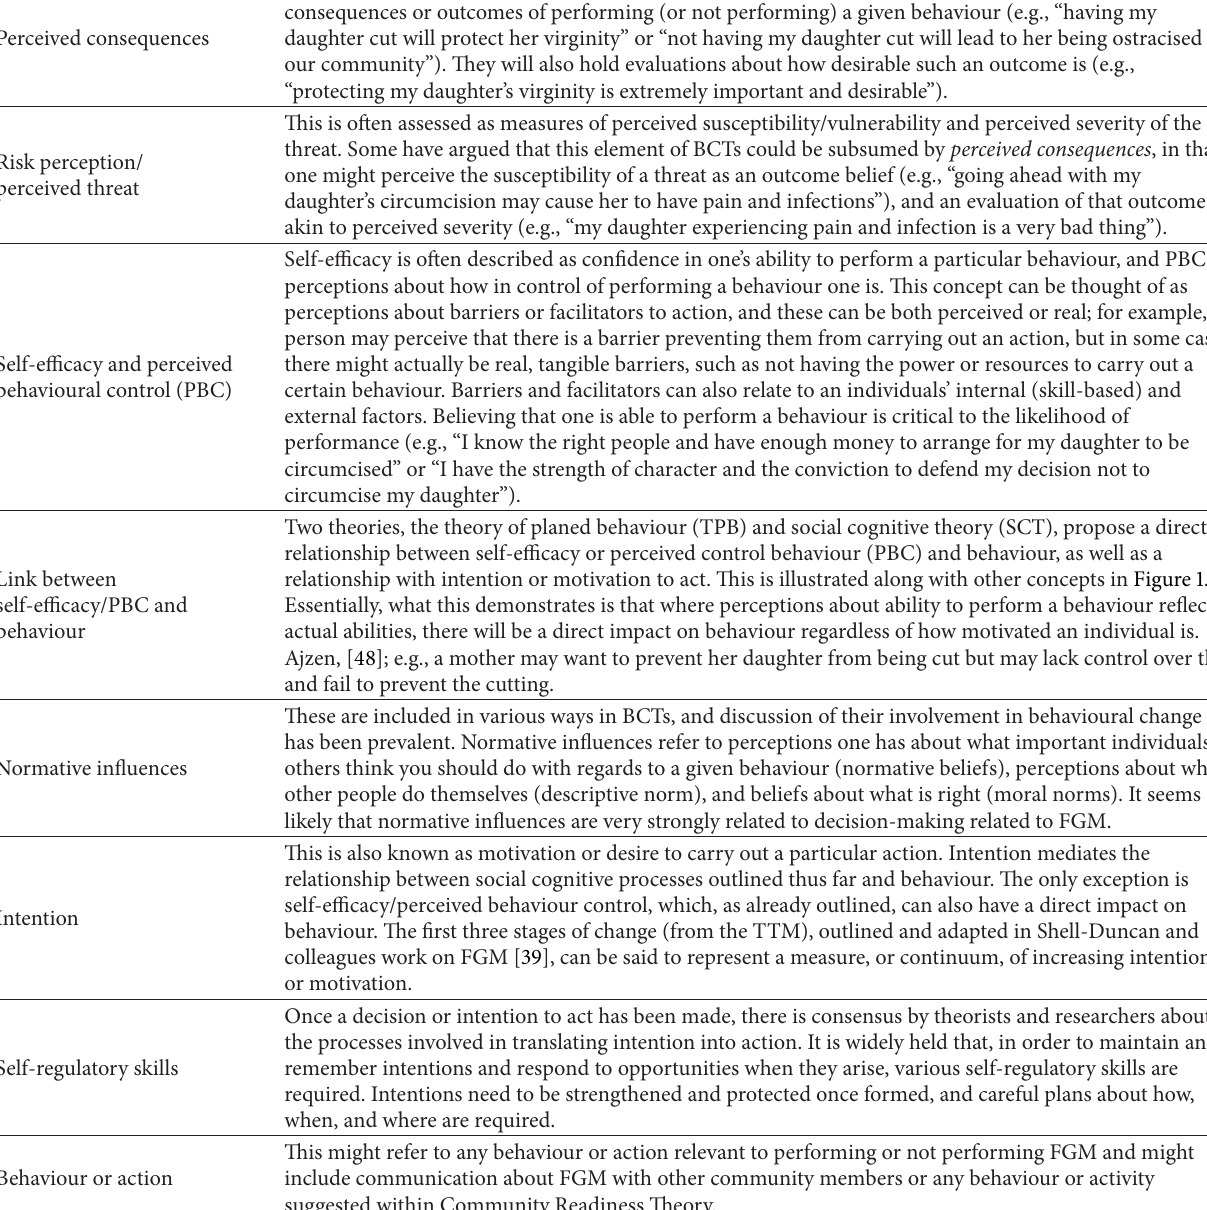
Table 2: Explanation of the major concepts from individualistic behaviour change theories (BCTs) adapted from Conner and Norman [57].